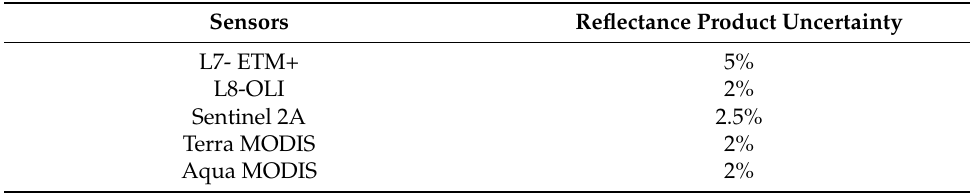
Table 4. Sensor calibration uncertainty for five different sensors